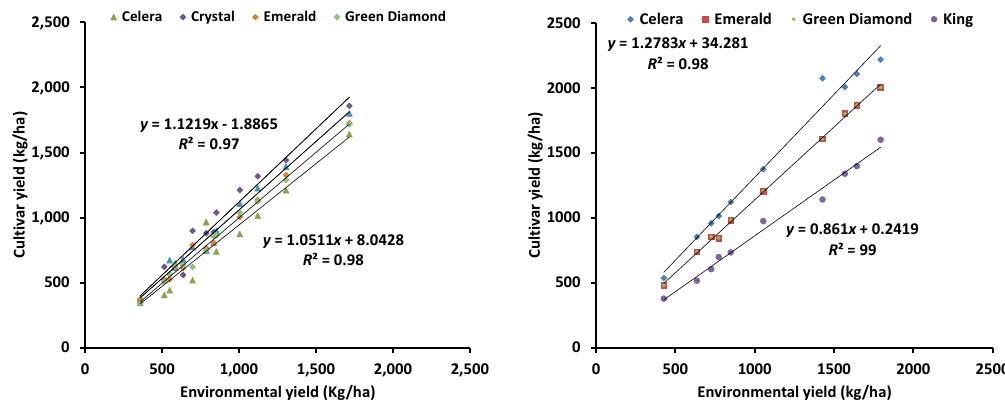
Figure 6. An example of the extent of G × E interactions in a mungbean trial with common cultivars ( left panel ) in multi-location trials and simulated ( right panel ) by the improved APSIM mungbean model [48] .